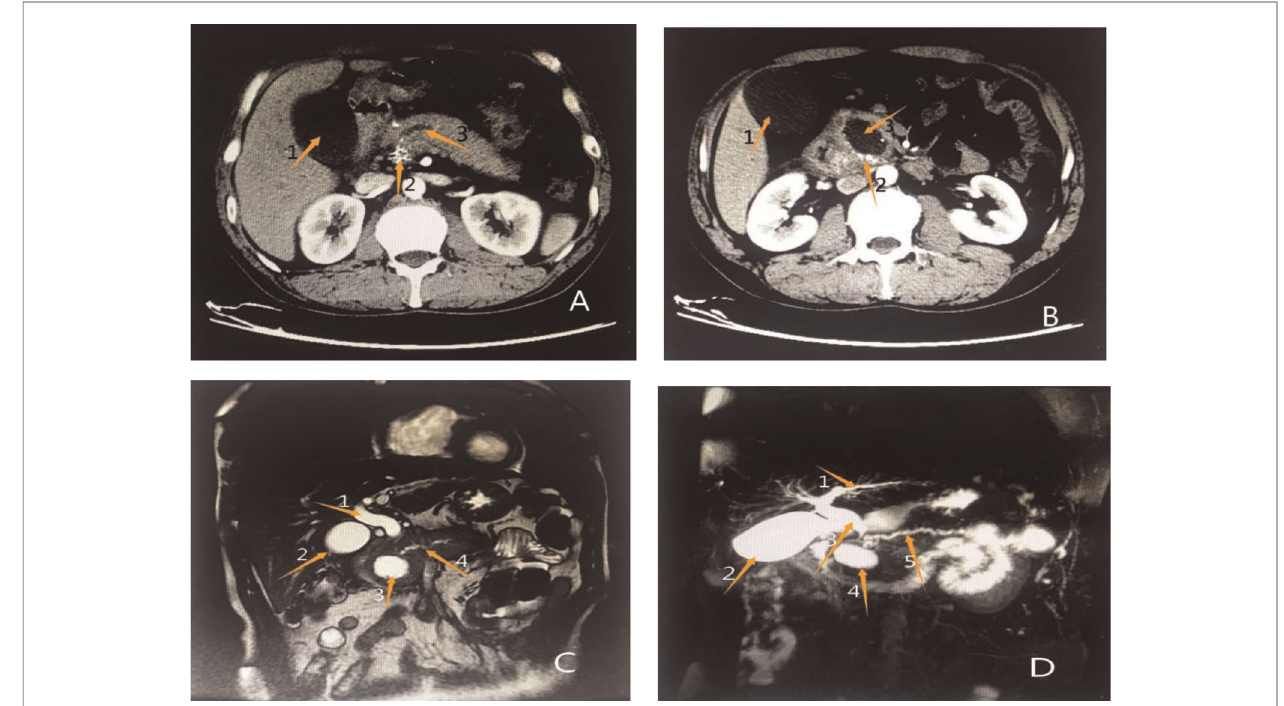
FIGURE 2 | Results of previous imaging examinations at another hospital ( A ) (enhanced abdominal CT): Arrow 1 shows an enlarged gallbladder, arrow 2 shows patchy enhancement of the pancreatic head, and arrow 3 shows a signi fi cantly dilated main pancreatic duct. ( B ) Enhanced abdominal CT: Arrow 1 shows an enlarged gallbladder, arrow 2 shows patchy enhancement of the pancreatic head, suggestive of pancreatitis, and arrow 3 shows a rounded, low-density shadow of the pancreatic head, considered a pseudocyst. ( C ) Abdominal MRI: Arrow 1 shows a dilated common bile duct, arrow 2 shows an enlarged gallbladder, arrow 3 shows a pseudocyst of the pancreatic head, and arrow 4 shows full dilation of the main pancreatic duct. ( D ) Abdominal MRCP: Arrow 1 shows a dilated intrahepatic bile duct, arrow 2 shows an enlarged gallbladder, arrow 3 shows a dilated common bile duct, arrow 4 shows a pseudocyst of the pancreatic head, and arrow 5 shows a fully dilated main